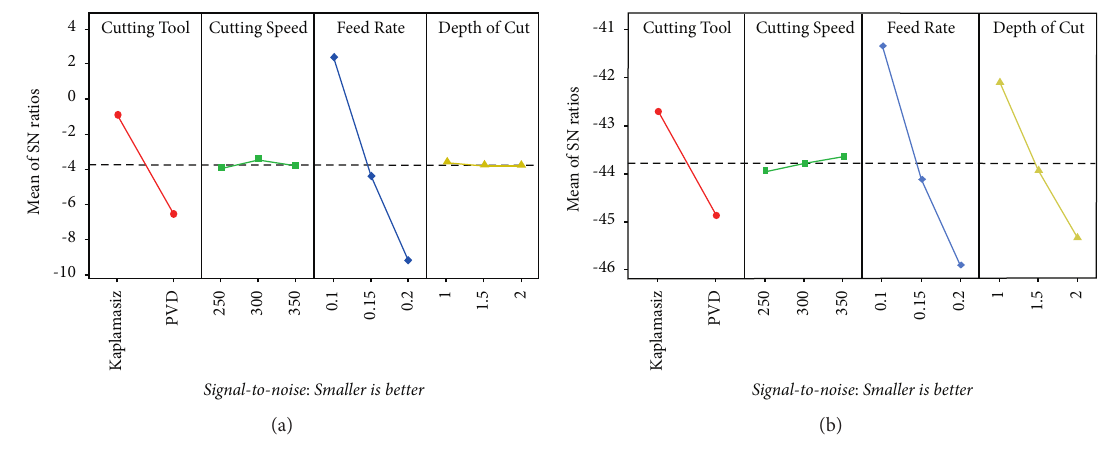
Figure 2: Main effects plot of S/N ratios for Ra (a) and Fc